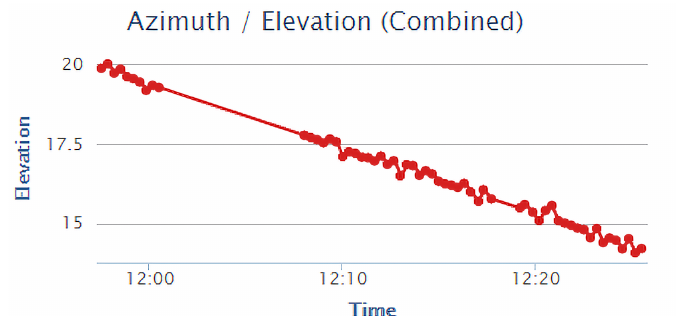
Figure 10. Tracked elevation of the Moon relative to TrackInk over time. A downward trend is visible as the Moon was setting at the time of recording this data. Visible noise in the data is due to variations in the IMU readings from user